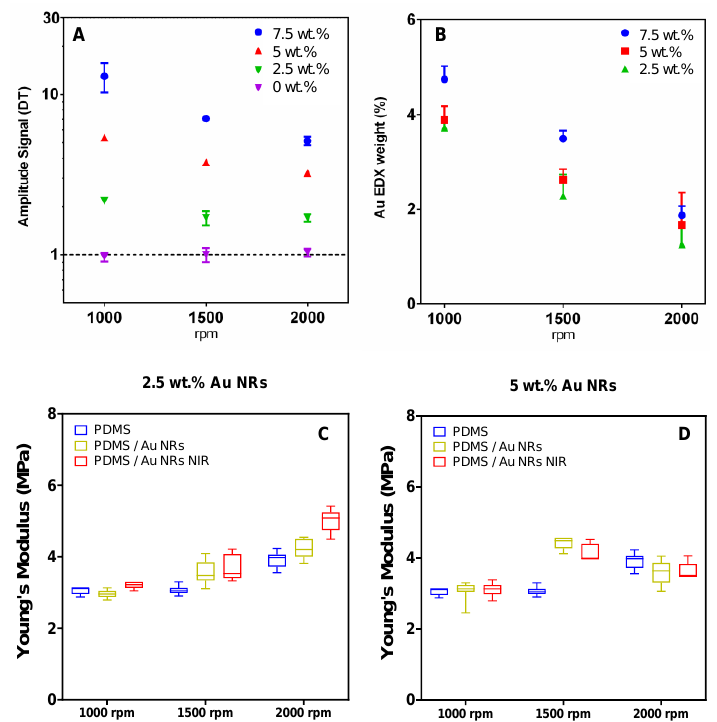
Figure A2. Influence of the spinning speed on the heat dissipation ( A ) and the amount of gold per unit of area ( B ) at 1000 rpm, 1500 rpm and 2000 rpm. Young ’ s Modulus was obtained using the Oliver and Pharr model ( n = 3) by nanoindentation for the films containing 2.5 wt.% ( C ) and 5 wt.% ( D